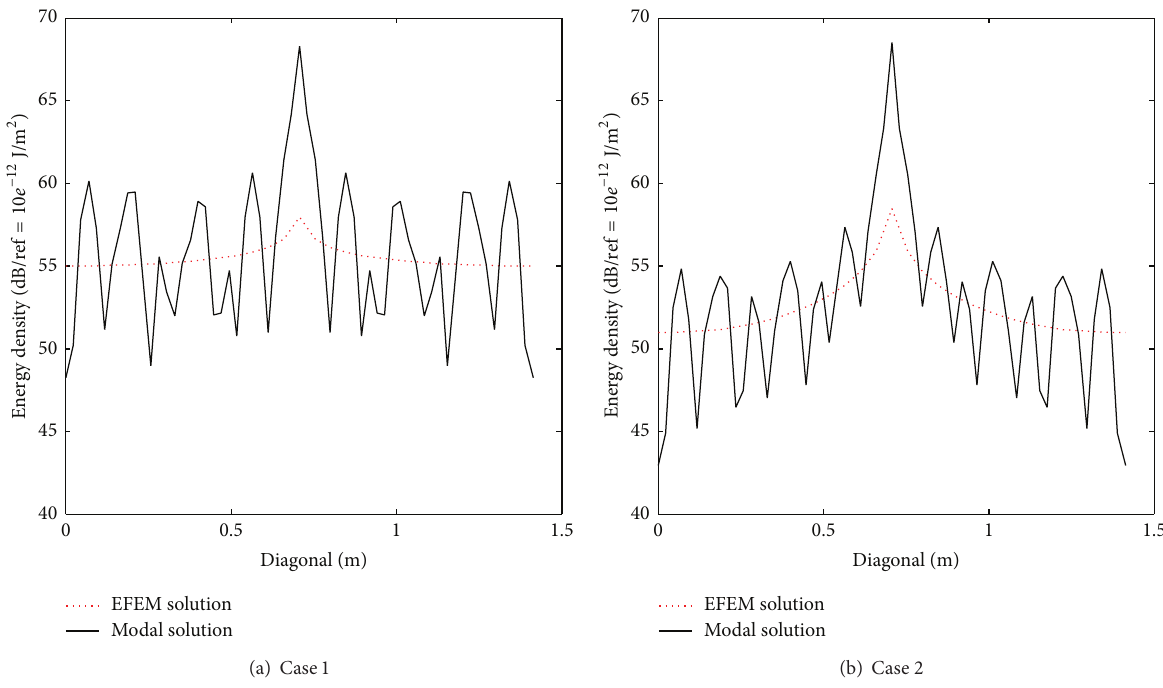
Figure 8: The energy density distribution comparisons between the two methods along the line 𝑦 = 𝑥 in case 1 and case 2.